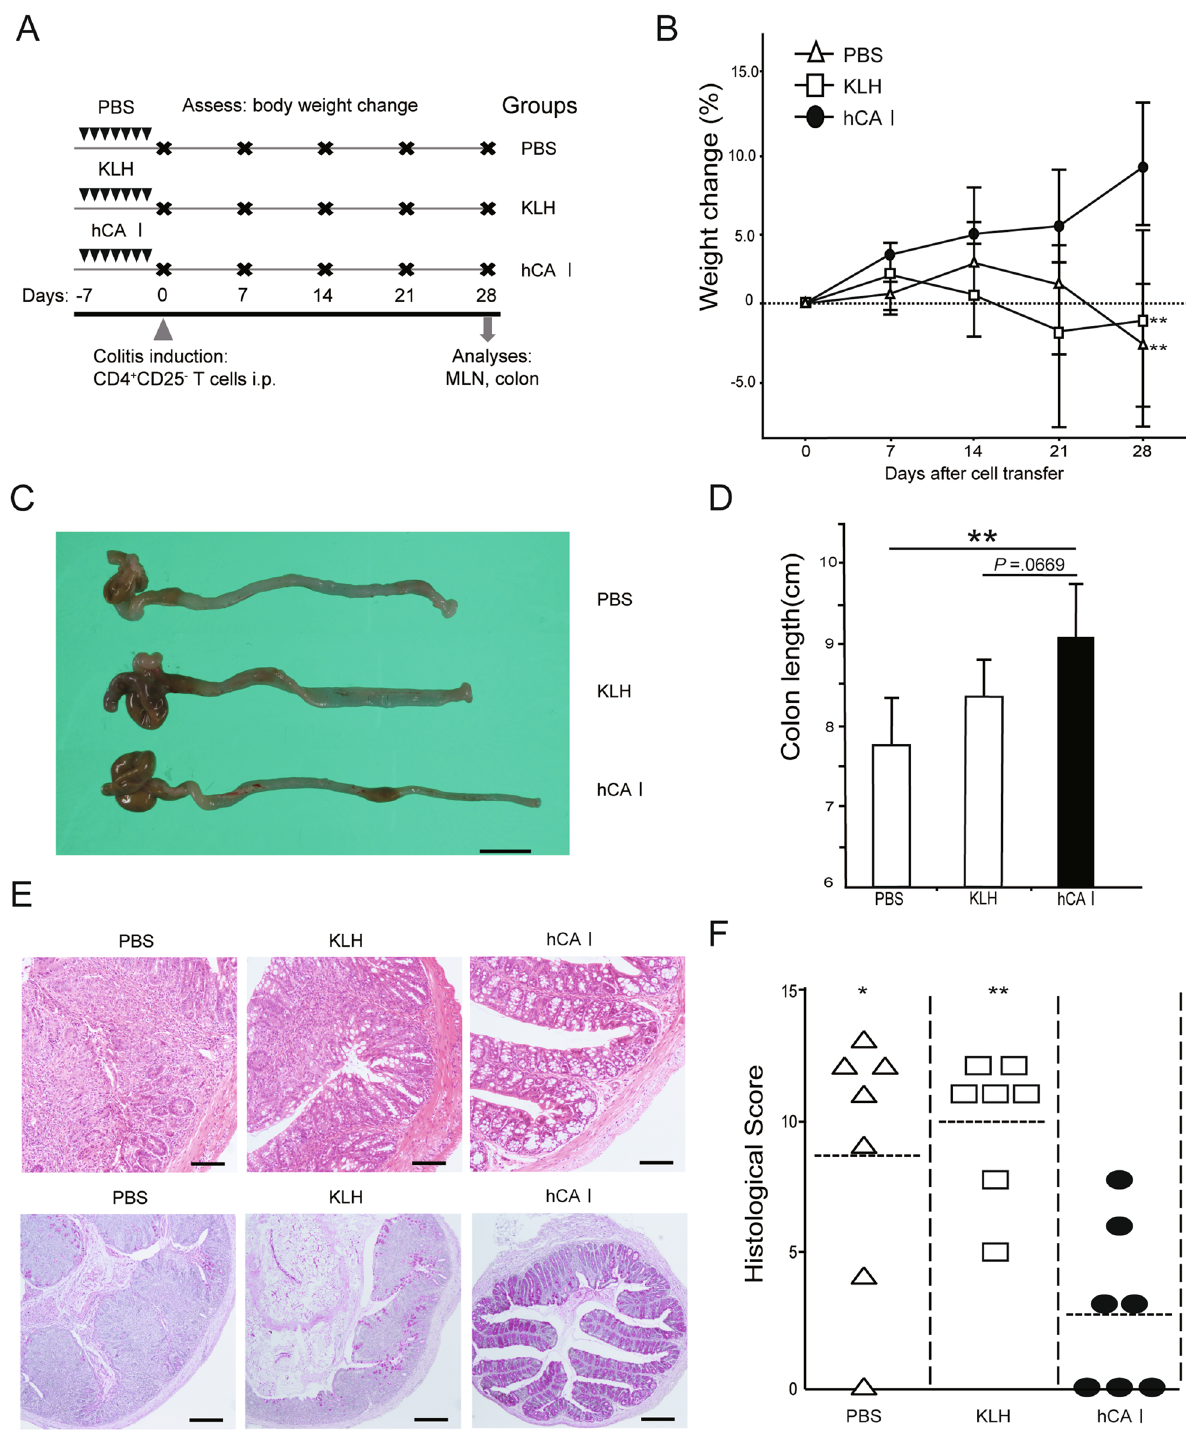
Figure 1. Oral tolerization using hCA I protects mice against experimental colitis. ( A ) Experimental protocol (see “Methods”). ( B ) Relative changes in body weight (%) over time at 0, 7, 14, 21, and 28 days. CD4 + CD25 − T cell (3 × 10 5 ) transfer model mice (n = 7 mice/group) were treated with PBS, KLH, and hCA I indicated as triangles, squares, and black circles, respectively. The error bars indicate SD. ( C ) Macroscopic findings of the colon on day 28. Scale: 10 mm. ( D ) Colon lengths in colitic mice on day 28 (n = 7). ( E ) Histological analysis of the colon on day 28. PBS- and KLH-treated mice demonstrated inflammatory cell infiltration, marked increase in mucosal height, and severe loss of goblet cells. Oral administration of hCA I improved these findings. Representative images at high (H&E stain; original scale: 100 μm) and low (periodic acid Schiff staining; original scale: 200 μm) magnifications are shown. ( F ) Histological scores on day 28. Horizontal bars: median. * P < 0.05; ** P < 0.01 (vs. hCA I-treated mice). Data shown are representative of two independent